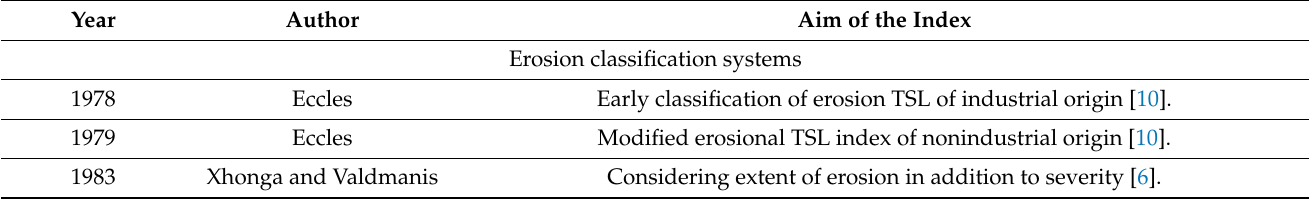
Table 1. TSL indices and classification